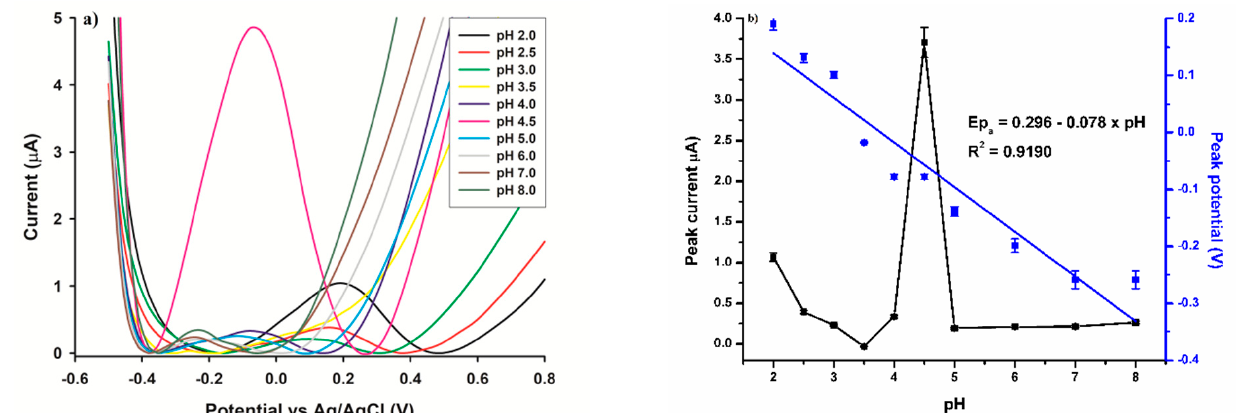
Figure 4. ( a ) Square wave voltammograms of 1.0 × 10 − 4 mol L − 1 Na 2 S 2 O 5 using the TPP/rGO@Pd0 sensor in PBS at pH values 2.0 − 8.0. ( b ) The effect of the pH on the peak current (black dots) and the linear dependence of the peak potential with the pH (blue line) .